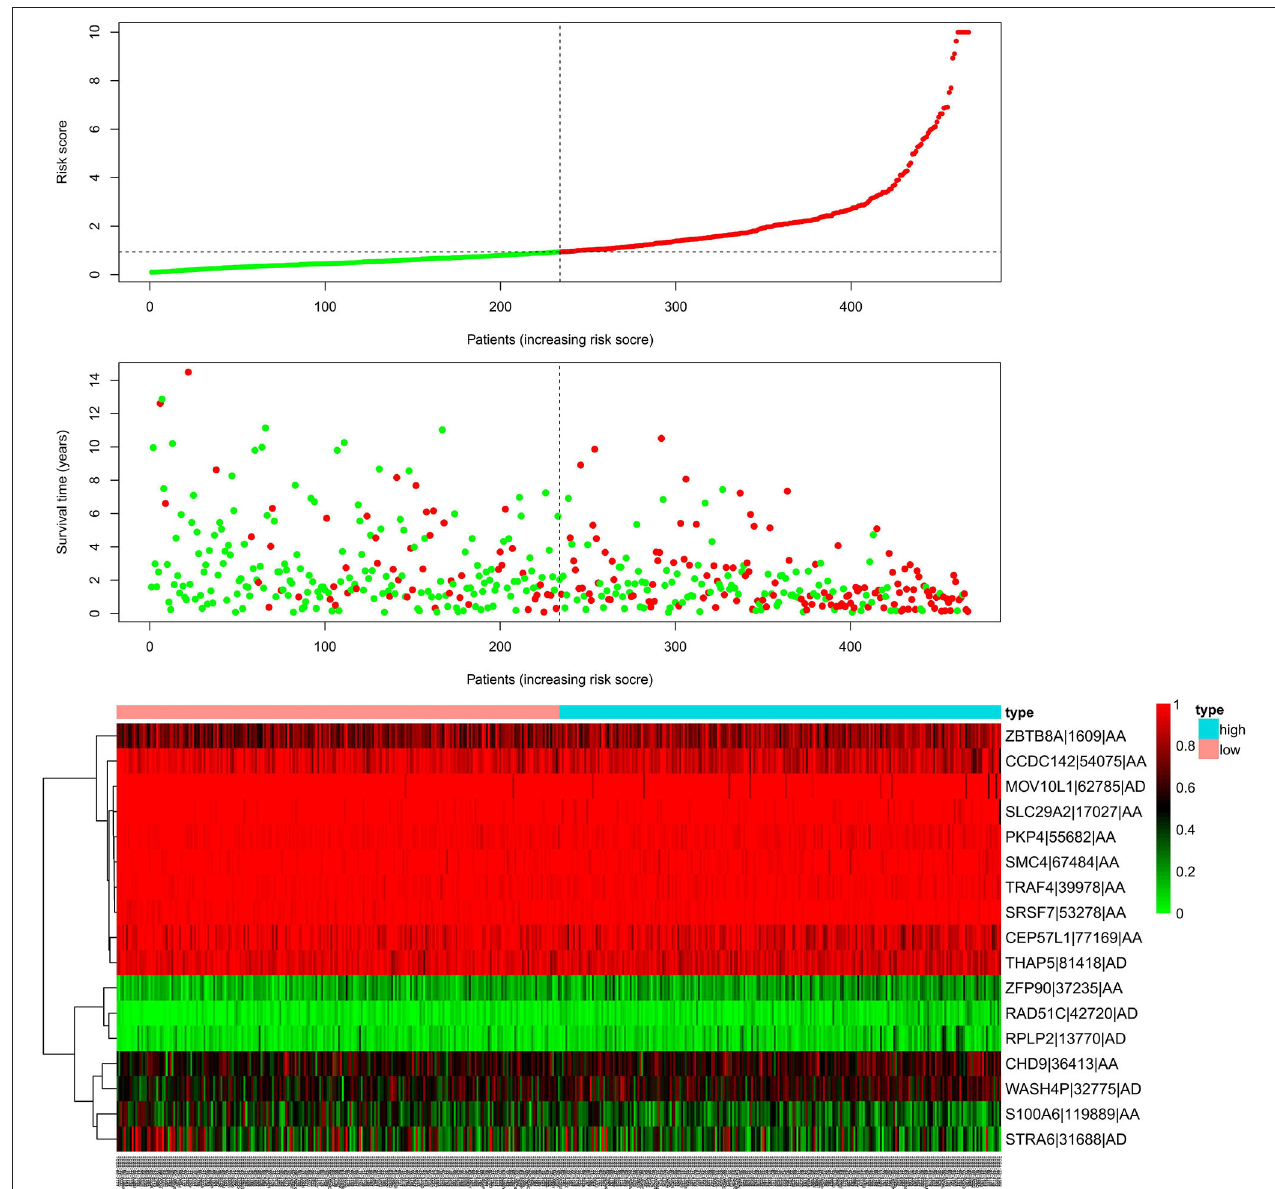
FIGURE 7 | Risk scores analysis of the final prognostic model. The upper part represents the risk score curves, the middle part indicates the distribution of patients’ survival time and status, and the bottom shows the PSI value heatmap for the final prognostic model. PSI, percent spliced